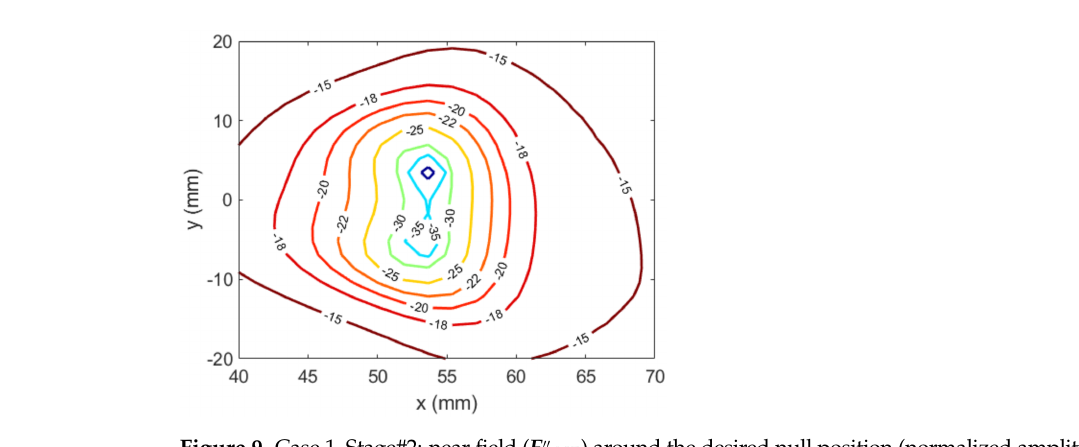
Figure 9. Case 1, Stage#2: near field ( E (cid:48)(cid:48) NF ) around the desired null position (normalized amplitude, dB).